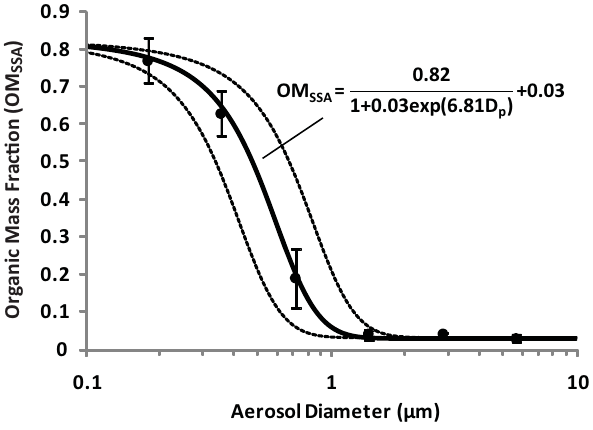
Fig. 4. Observed organic mass fraction of sea spray aerosol (solid circles) as a function of ambient aerosol aerodynamic diameter from Facchini et al. (2008). The solid curve shows a logistic fit to the ge- ometric mean of the diameter range, with the dashed curves corre- sponding to the logistic fit of the high and low end of the individual aerodynamic size ranges. Vertical bars show one standard deviation from the mean as described in Facchini et al.